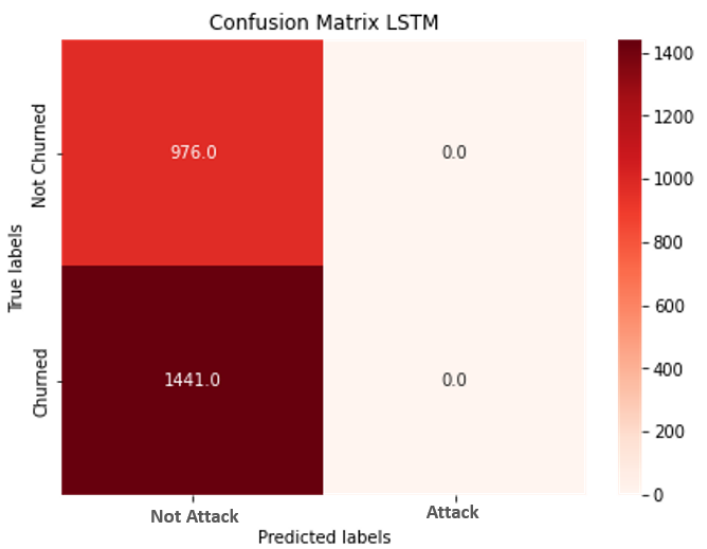
Figure 14. Confusion matrix on prediction of